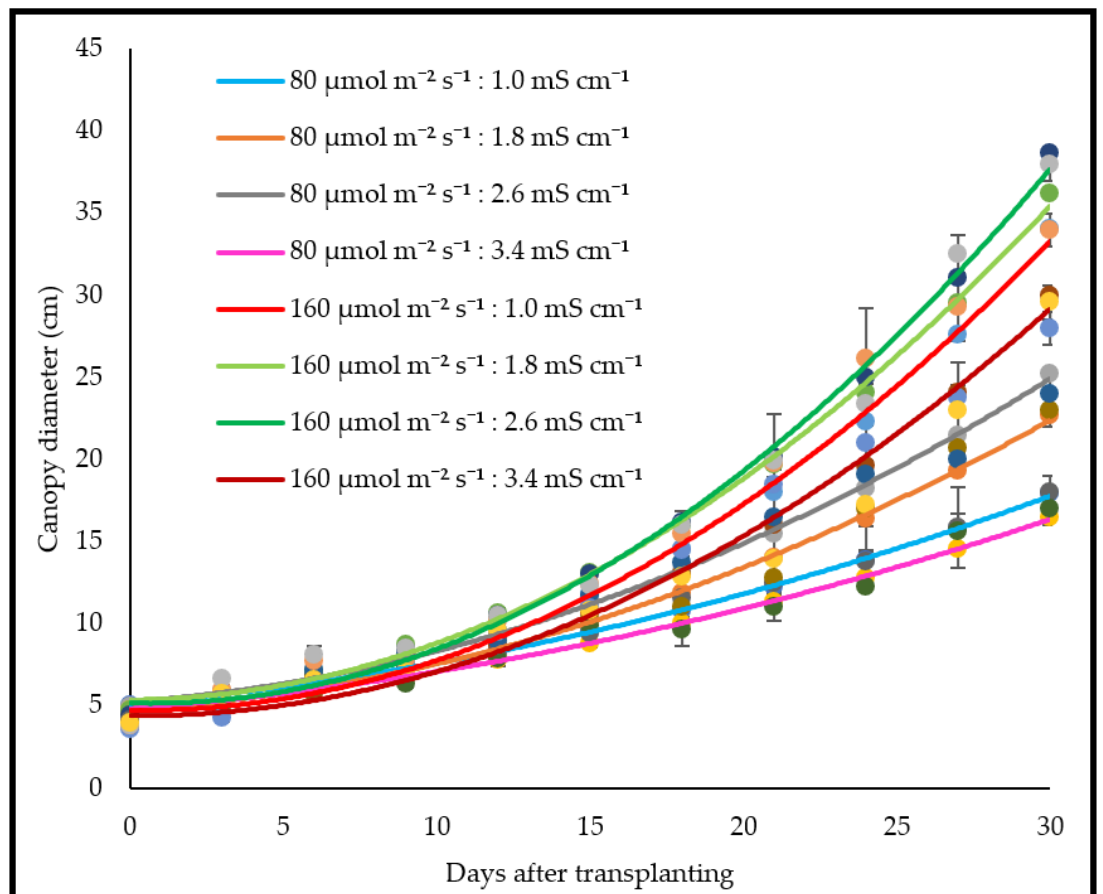
Figure 2. Canopy diameter of lemon basil for 30 days growing duration under different LEDs and nutrient solution